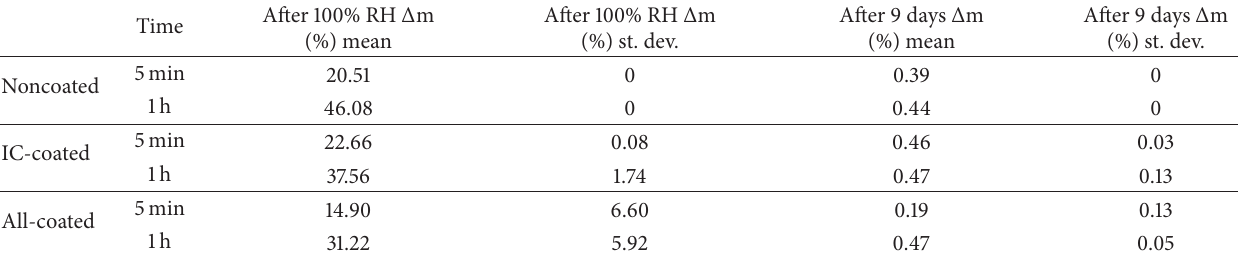
Table 2: Results of moisture absorption: mean change in mass and standard deviation after each testing